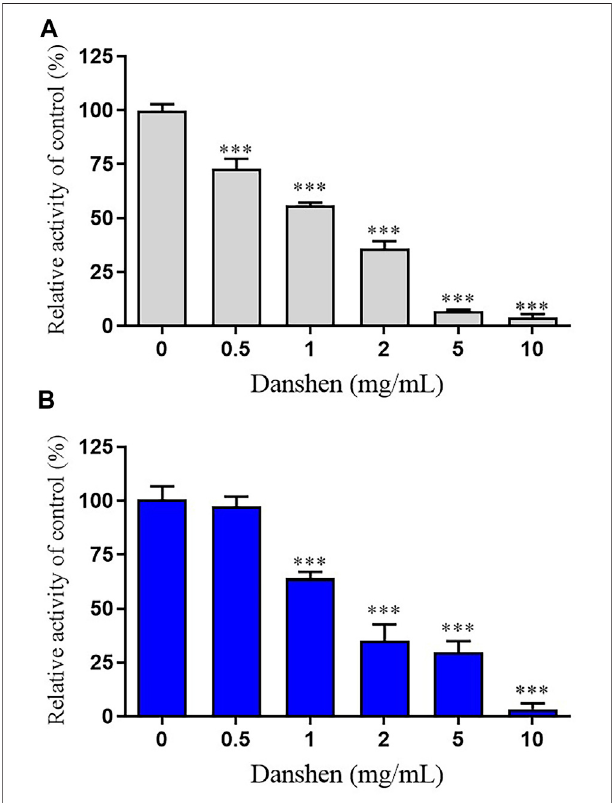
FIGURE1| InhibitionofrivaroxabanmetabolismbyDanshentabletinrat liver microsomes (RLM) (A) and human liver microsomes (HLM) (B) . Results were mean ± SD of quadruplicate determinations. *** p < 0.001 compared to control (no inhibitor).